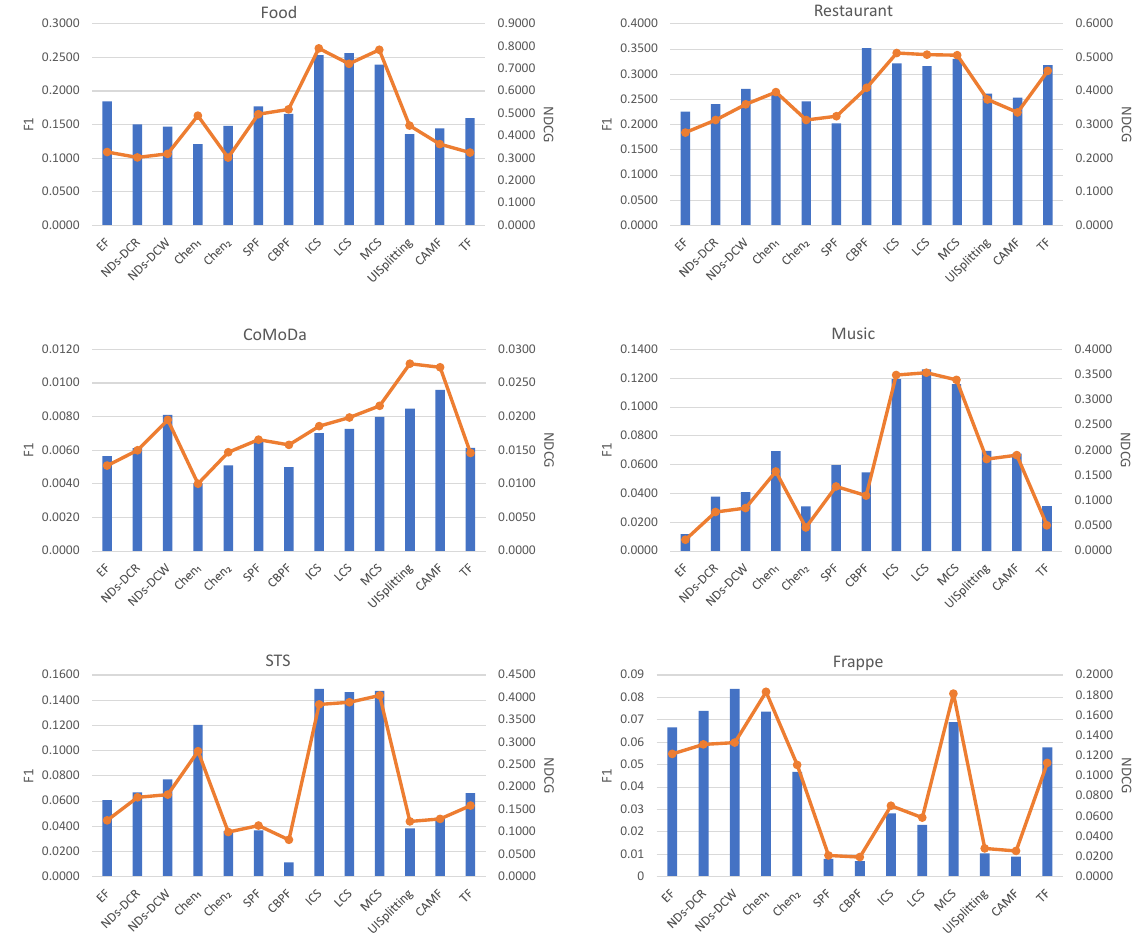
Figure 4. Results of top-10